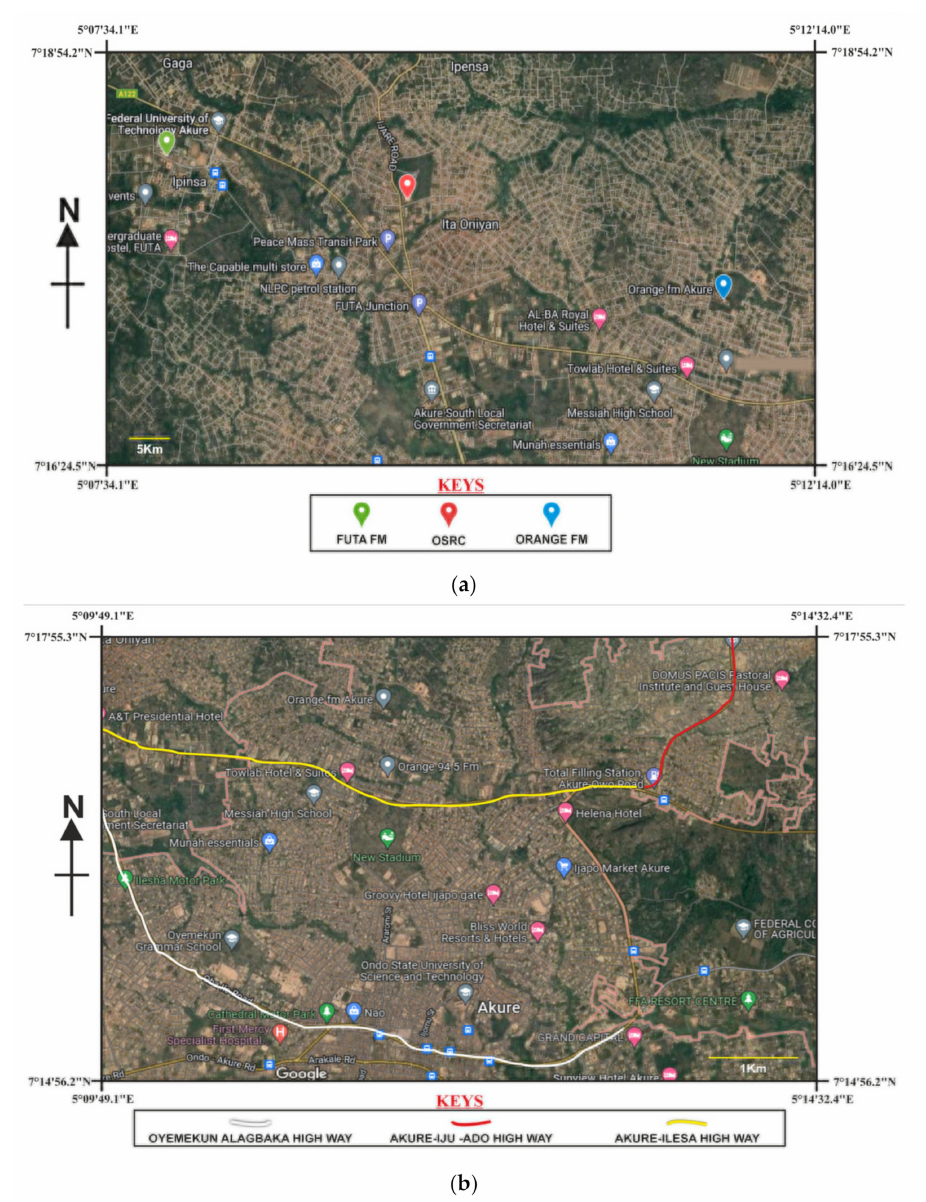
Figure 1. Map of the study area. ( a ) Akure metropolis showing the location of the base stations. ( b ) Measurements campaign routes.